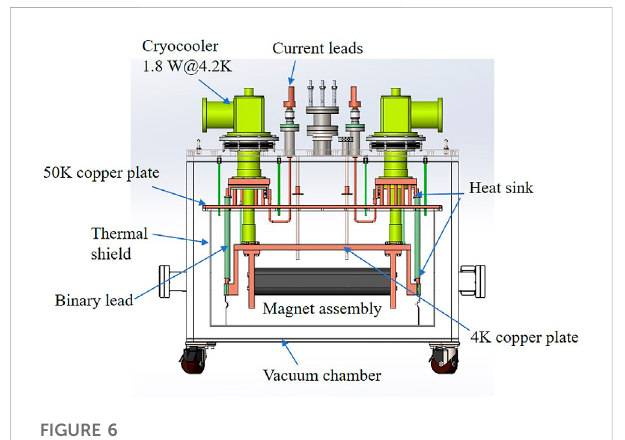
FIGURE 6 Schematic drawing of the LHe-free cryostat.